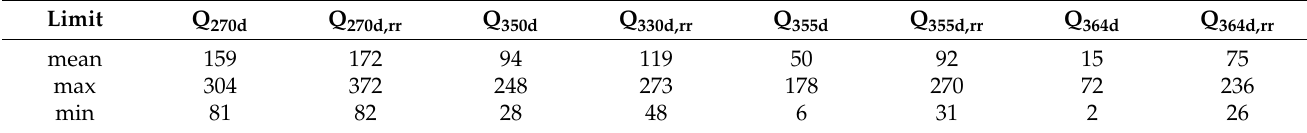
Table 4. The number of days with Q d < limit for the five longest low-flow episodes at each